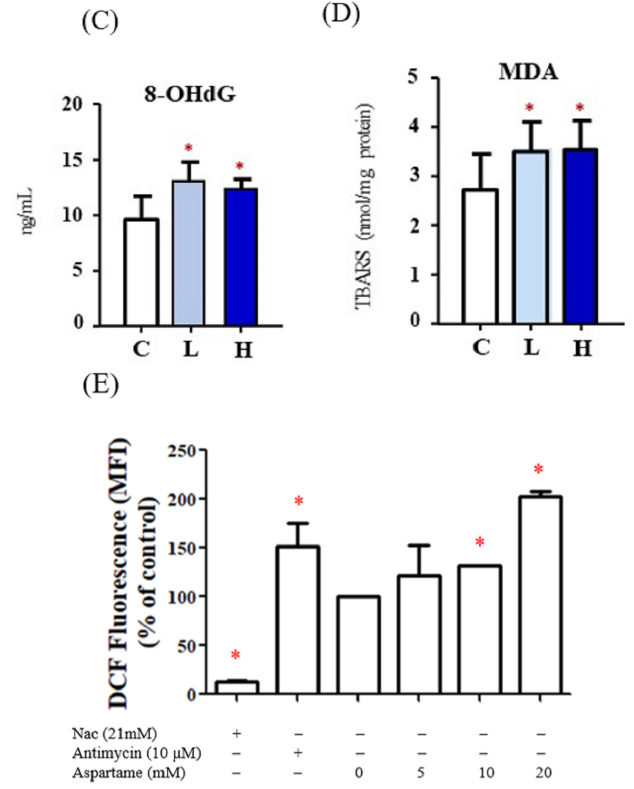
Figure 2. Effect of aspartame treatment on the protein levels of antioxidant enzymes and oxidative stress in rats and cells. Aspartame-treated groups contain lower antioxidant enzymes and higher oxidative stress in ovary and KGN cells. ( A ) The protein levels of catalase (60 kDa), the most abundant and effective enzyme in cytosol (n = 5). ( B ) The protein levels of superoxide dismutase-2 (25 kDa), a mitochondrial antioxidant enzyme (n = 5). The western blot data are normalized with GAPDH so that value of the control is regarded as 1.0. ( C ) 8-OHdG levels, oxidative stress caused DNA damage (n = 5). ( D ) MDA, oxidative stress caused lipid peroxidation (n = 5). ( E ) After KGN cells were treated with 5–20 mM aspartame for 48 h, cells were collected and stained with DCFDA followed by flow cytometry analysis. Quantitative results of ROS are shown in the plot (n = 3). NAC (N-acetyl-l-cysteine) was used as negative control. Antimycin was shown as positive control. All data are expressed as mean ± SD. * p < 0.05 as compared with control. C, control. L, low dose of aspartame. H, high dose of aspartame. CAT, catalase. SOD, superoxide dismutase. 8-OHdG, 8- hydroxy-2-deoxyguanosine. MDA, malondialdehyde. TBARS, thiobarbituric acid reactive substances. MFI, medium fluorescence